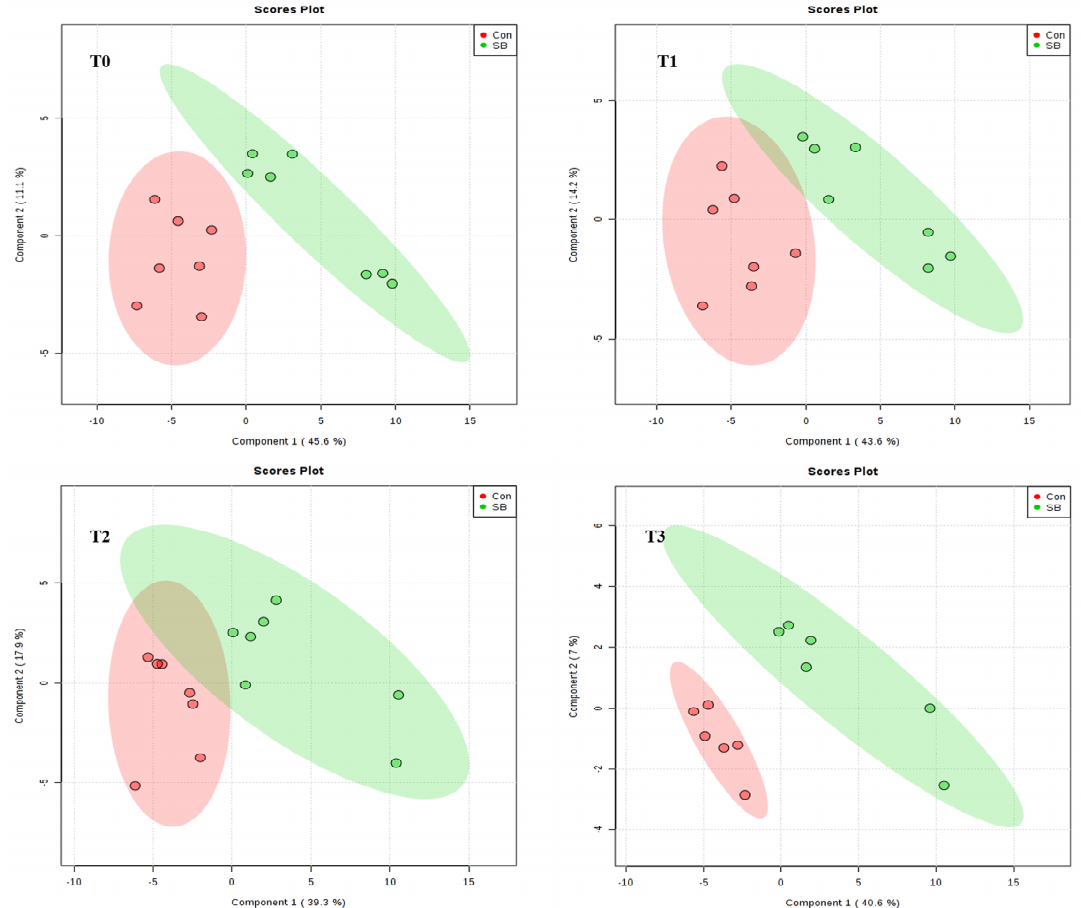
Figure 4. Partial least squares discriminant analysis (PLS-DA) score plot of metabolites of pigs in the control (Con) and sodium butyrate (SB) groups at T0 (0 min, n = 7), T1 (30 min, n = 7), T2 (60 min, n = 7), and T3 (120 min, n = 6) after intravenous infusion. Component 1 = the first principal; Component 2 = the second principal. The explained variances of the first two components are shown in brackets, respectively. The ellipse represents the 95% confidence interval of each